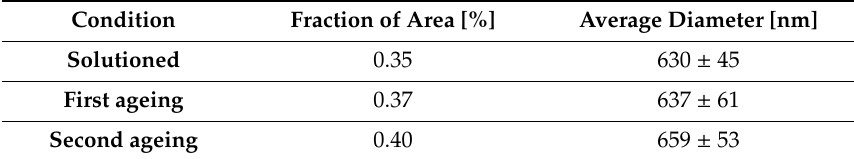
Figure 13. EDS spectra comparing the matrix (solid black line), Mo carbides inside a grain (black dotted line) and Cr carbides at the grain boundary (solid gray line). Table 4. Evolution of fraction of area occupied by carbides and their average diameter in HT samples from solutioning to second aging. Condition